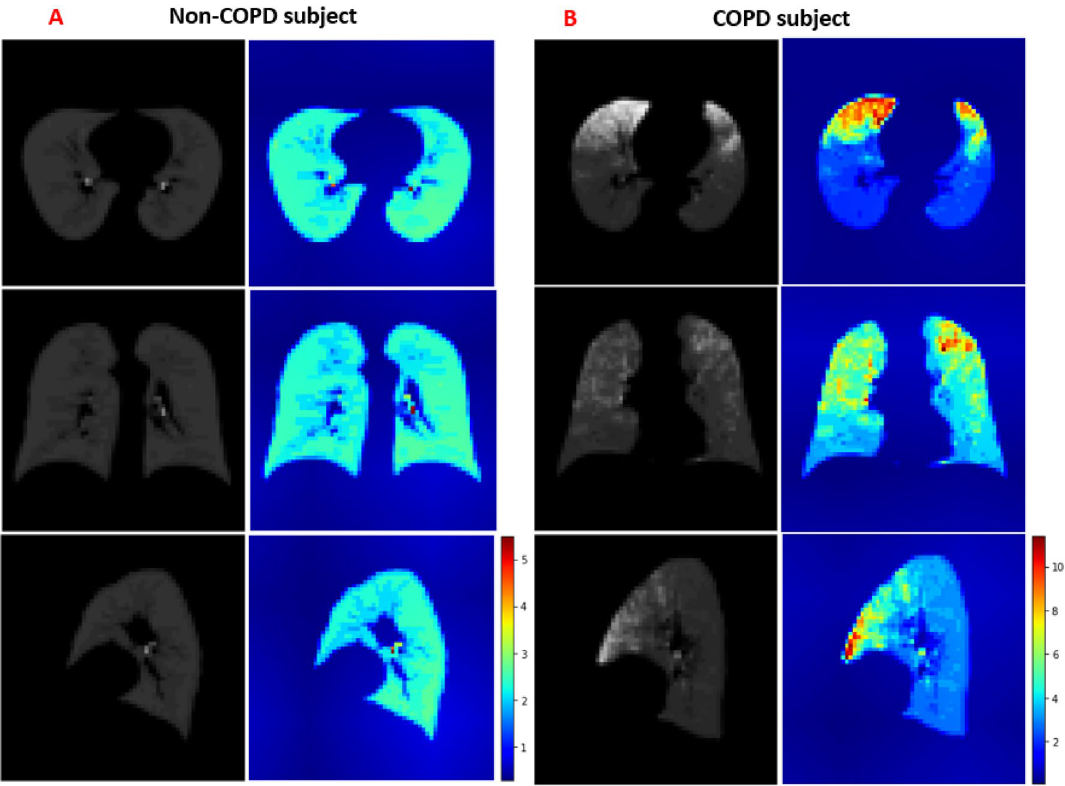
Figure 7. Axial (top), sagittal (center), and coronal (bottom) views of PRM images (gray) and their Grad-CAM heatmap images (color), generated from non-COPD ( A ) and COPD ( B ) subjects. This figure was generated with